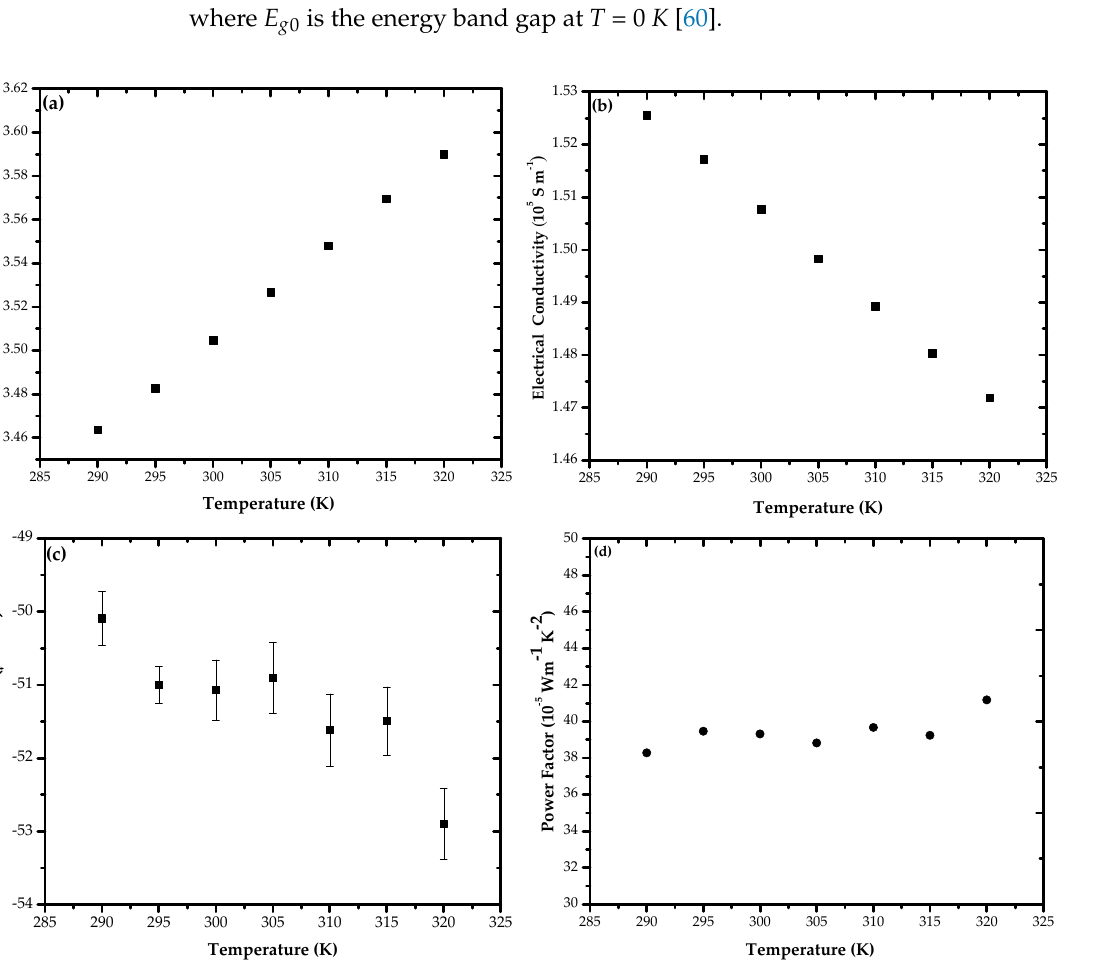
Figure 6. ( a ) Thermal conductivity κ , and ( b ) figure of merit ZT values of Bi 2 Se 3 NW in the temperature range of 290K to 320K.